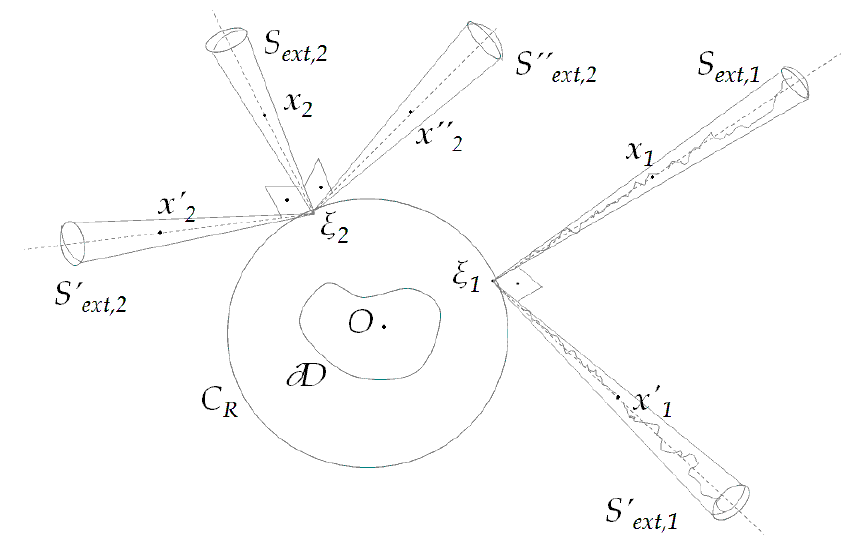
Figure 7. Transferring data from the far field to the near field